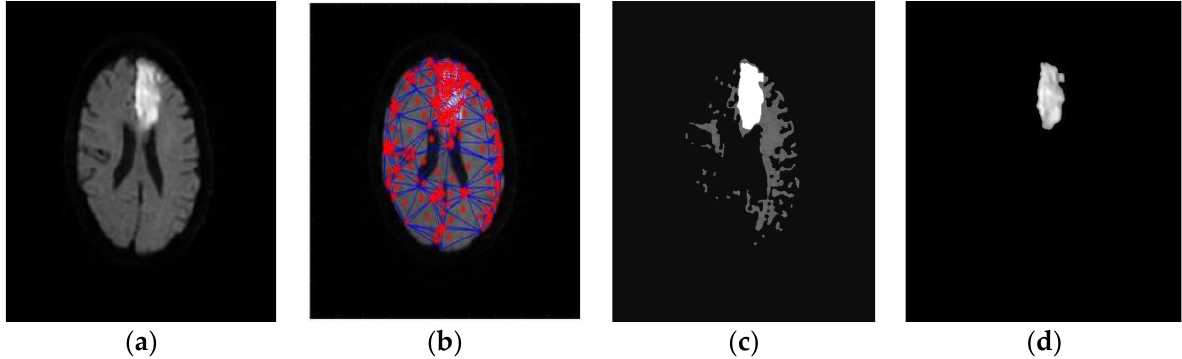
Figure 7. Ischemic stroke lesion is seen on the original DWI ( a ), Voronoi cells are generated ( b ), and Delaunay triangulation applied ( c ), The extracted lesion detected using Delaunay triangulation FODPSO ( d ) [114].